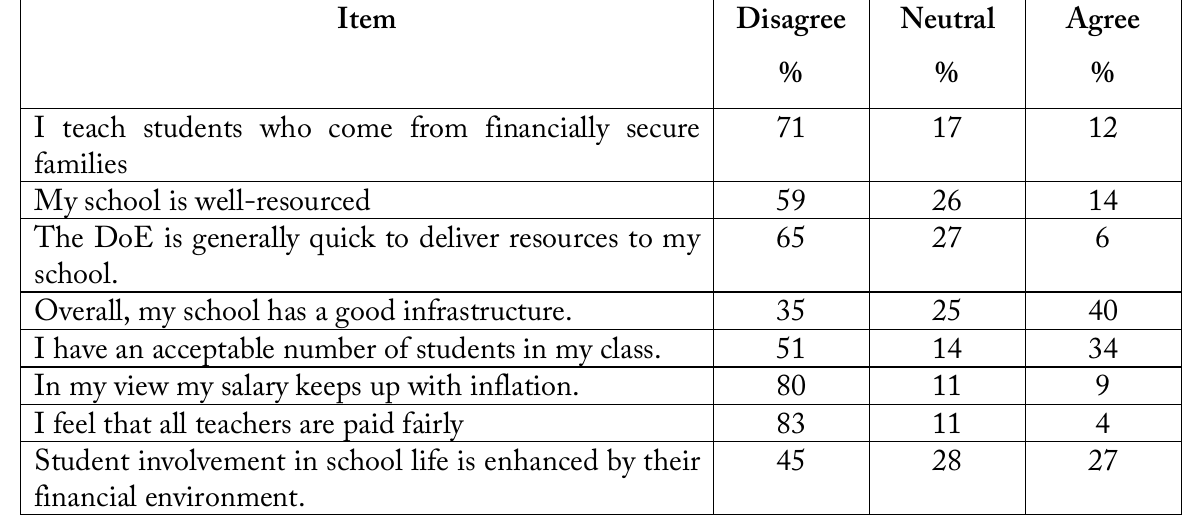
Table 2: Perceptions of the physical and financial working context Item